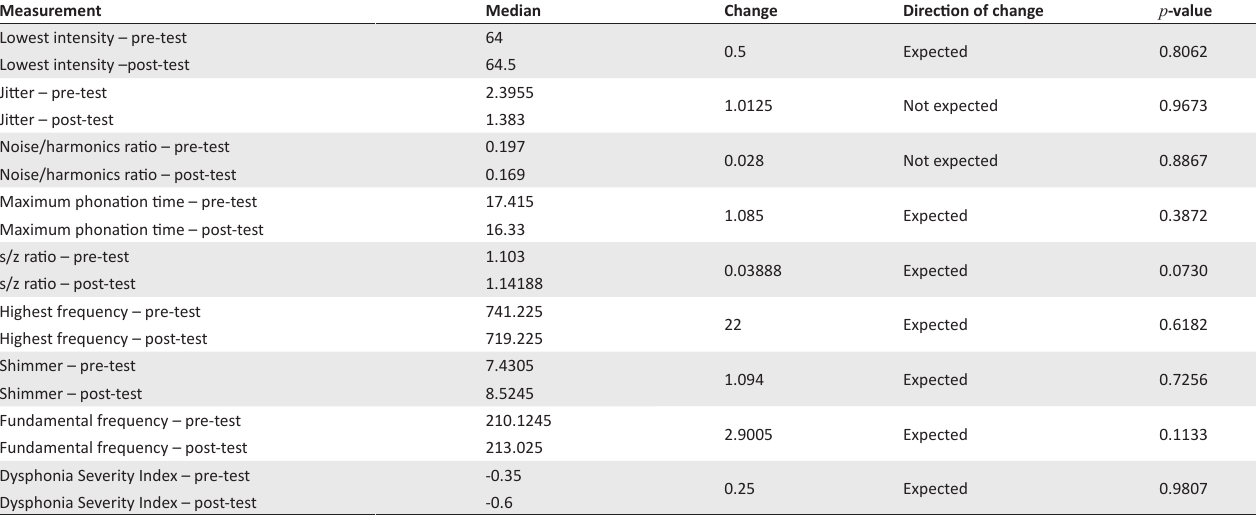
TABLE 5: Acoustic analysis results across all